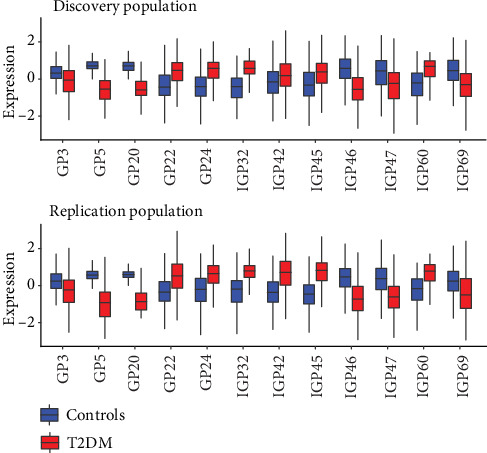
Distribution of IgG glycan peaks and traits associated with type 2 diabetes. Upper half: distribution of glycans in the discovery population. Bottom half: distribution of glycans in the replication population. This figure shows the relative expression of each glycan for controls (blue) and cases (red).